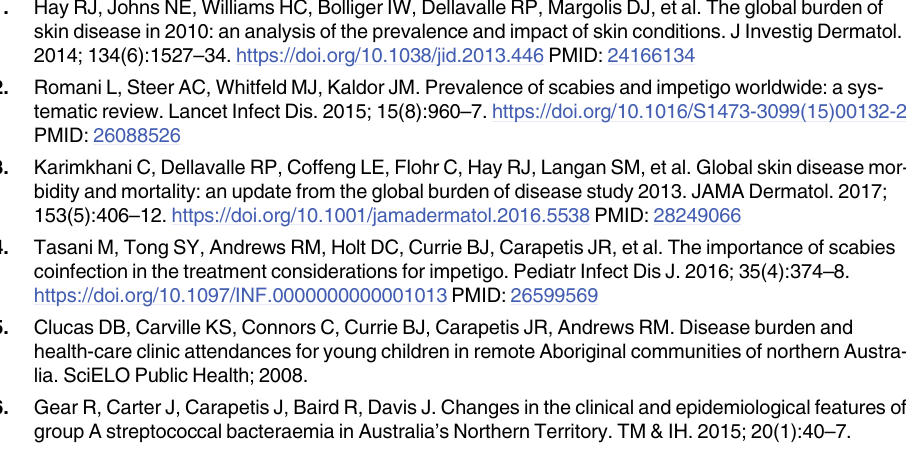
S13 Table. RNA interference pathway components in Sarcoptes scabiei .